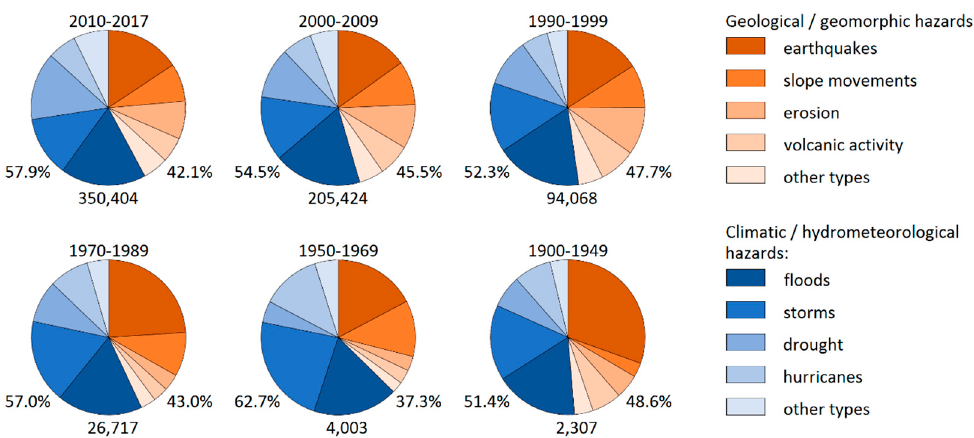
Figure 1. The share of major types of natural hazards in different time periods. The numbers show the total number of research items and the percentages show the share between research items dealing with the geological/geomorphic natural hazards and research items dealing with the climatic/hydro-meteorological natural hazards.